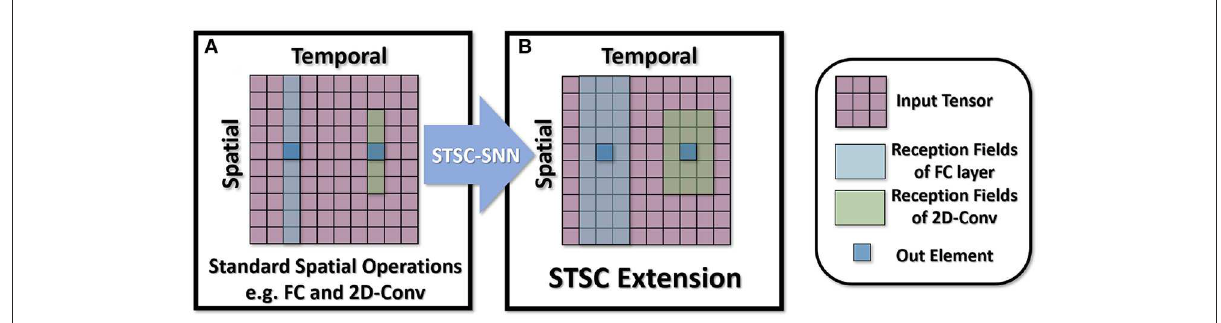
FIGURE1 Illustration of receptive fields in synaptic connections. (A) The receptive fields of typical spatial operations used in SNNs, e.g., fully-connected layers (full) and 2D convolutional layers (sparse); (B) The STSC modules proposed to extend spatial operations with spatio-temporal receptive